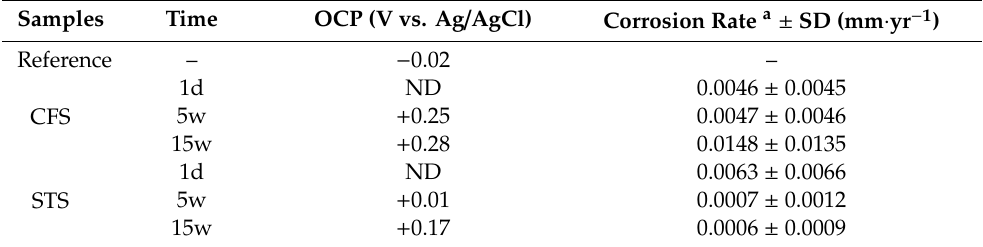
Figure 4. Weight loss of coupons exposed to seawater in the CFS ( (cid:4) , green) and STS ( (cid:95) , purple) set-up. The sampling times were 0.1 (1 day), 5, and 15 weeks. w: weeks. Table 1. Electrochemical and deterioration analysis of stainless steel 316L after exposure to natural